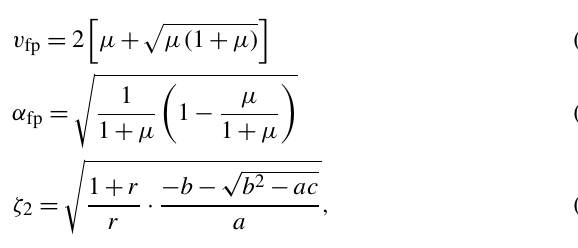
optimization by the canonical PSO, GA, and AM–PSO pa-